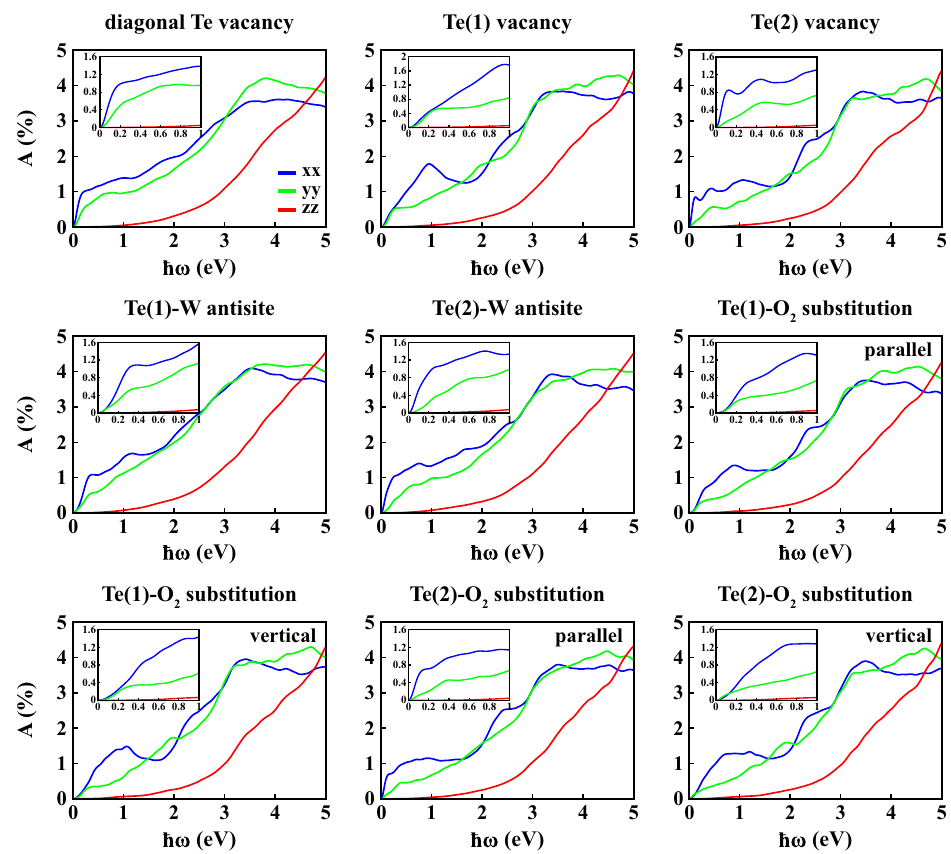
Figure 10. Absorbance ( A ) as a function of photon energy ( (cid:31) ω ) calculated within PBE+SOC at 0 K along crystallographic axes ( xx , yy , zz ) for 1L defective 1T ′ WTe 2 .